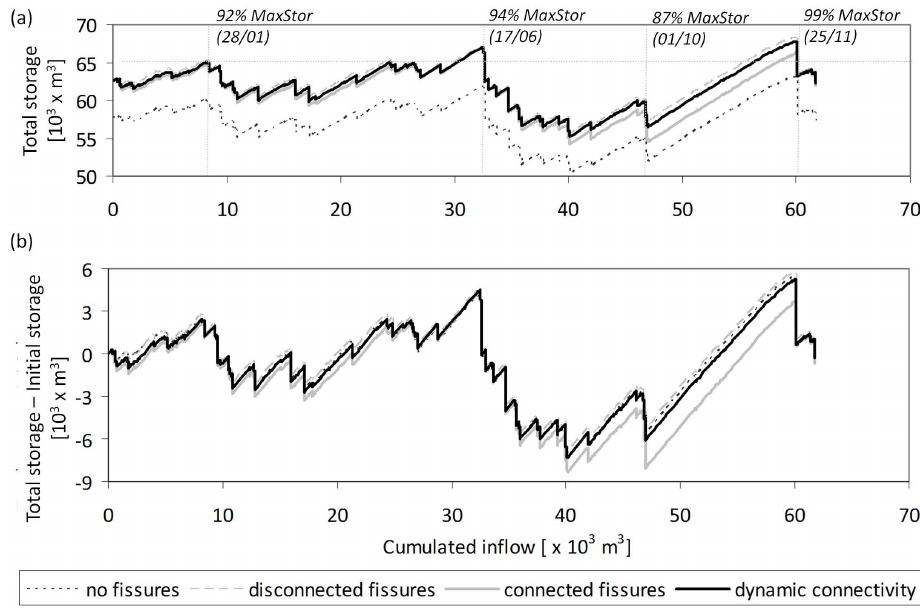
Fig. 4. Variation in total storage during one-year simulation period expressed as a relationship between cumulative inflow (total rain volume) and changes in storage compared to initial